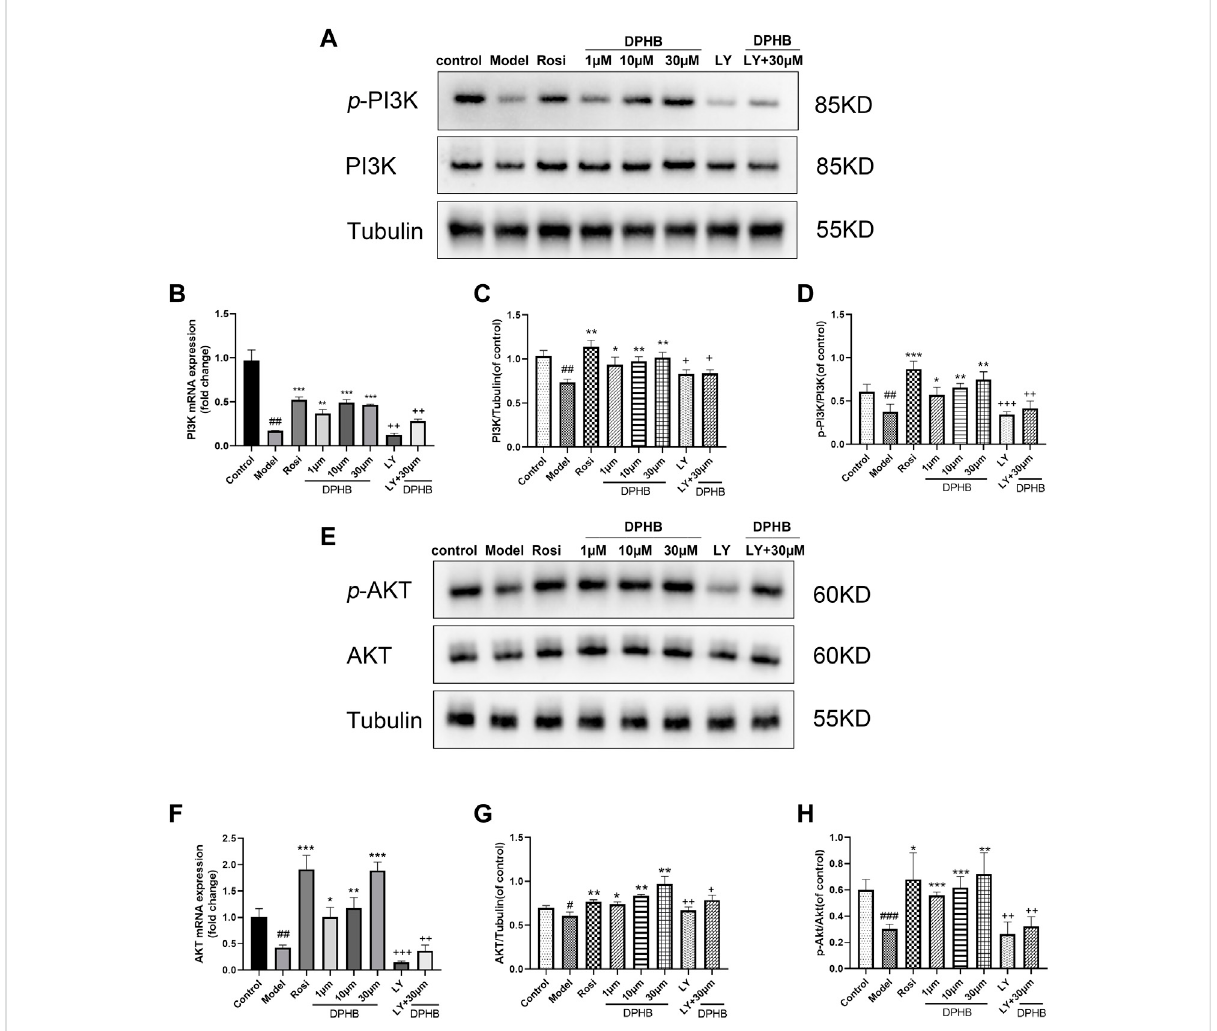
FIGURE 6 Effects of DPHB on the PI3K/AKT signaling pathway in IR-3T3-L1 adipocytes. (A) Protein expression of PI3K; (B) mRNA expression of PI3K; (C) quanti fi cation of PI3K; (D) quanti fi cation of p -PI3K; (E) protein expression of PI3K; (F) mRNA expression of AKT; (G) quanti fi cation of AKT; and (H) quanti fi cation of p -AKT. All values are expressed as means ± SD, ( n ≥ 3). * p < 0.05, ** p < 0.01, and *** p < 0.001, when compared with the model control group; ## p < 0.01 and ### p < 0.001, when compared with the control group; and + p < 0.05, ++ p < 0.01, and +++ p < 0.001, when compared with the 30- μ M DPHB